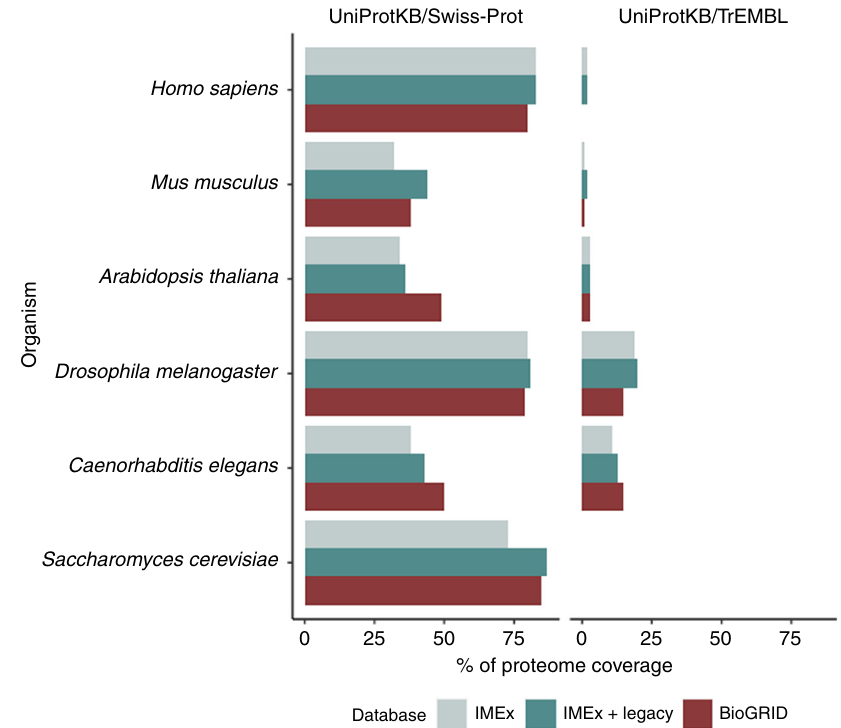
Fig. 3 Coverage of UniProtKB model organism proteomes in interaction databases. Shown is the fraction of all proteome entries of key model organisms represented in UniProtKB/Swiss-Prot (manually reviewed) and UniProtKB/TrEMBL (computationally inferred) that are found in primary interaction databases (IMEx, IMEx + legacy data and